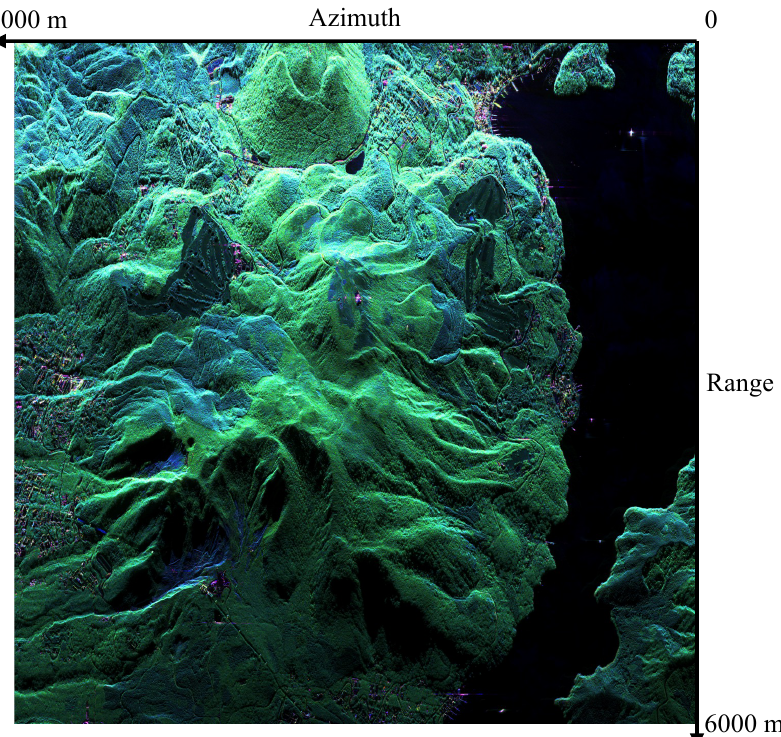
Figure 10. G4U image after calibration around Mount Hakone on 3 December 2015 (Center: N35.218,